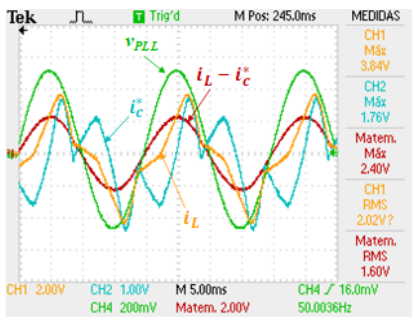
Figure 13. Experimental results of the proposed SAPF with reduced dc link concerning the Fryze theory: Load current, i L ; Compensation current reference, i* c ; Theoretical source current, ( i L - i* c ); Signal generated by the EPLL, v PLL .